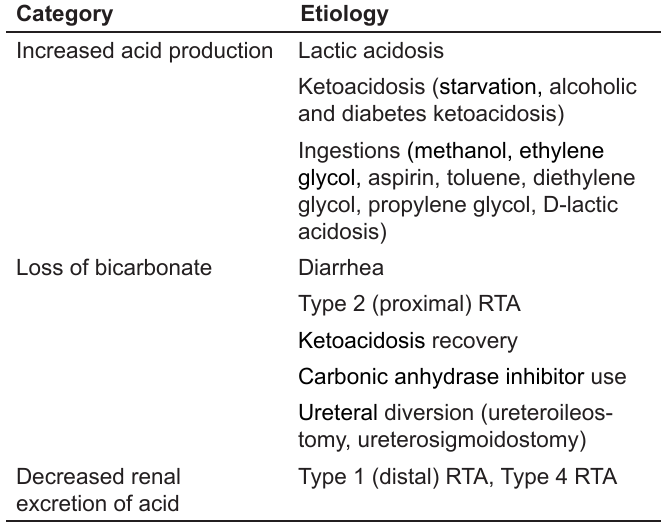
Table 3 . Categories and etiologies of non-anion gap